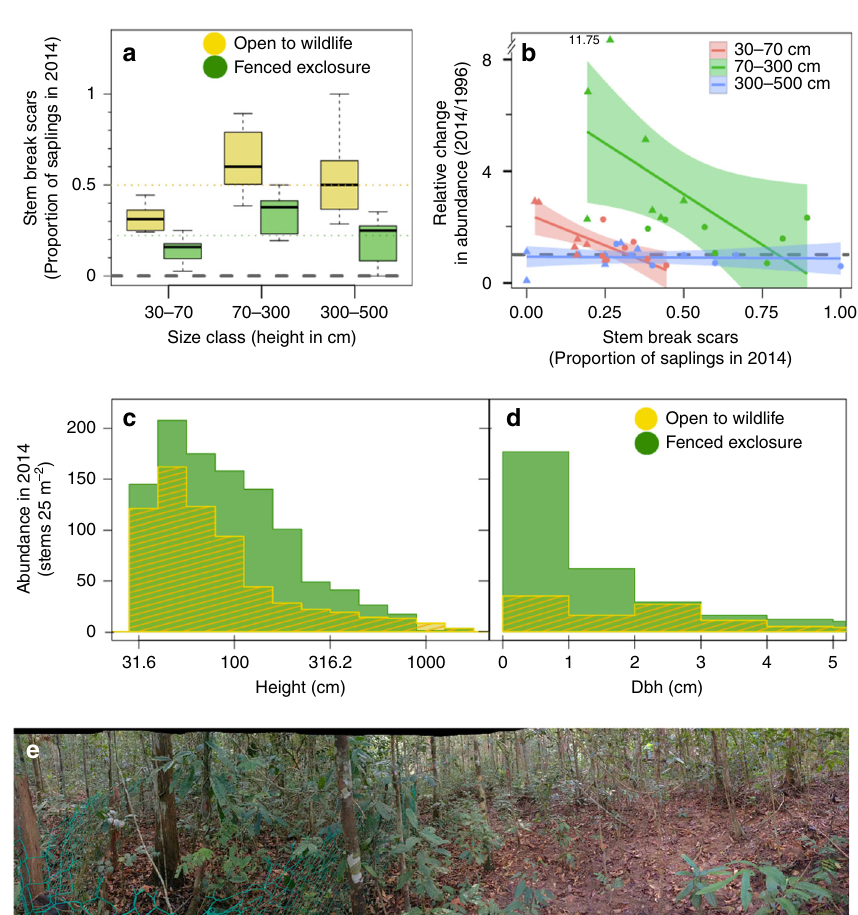
Fig. 3 Impacts of wild boar disturbance on the forest understory. a Different stem break scars in wildlife exclosures (green) compared to open control plots in 2014 (yellow) ( n = seven replicates of 25 m 2 exclosure plots and paired controls). Colored dashed lines show group means. Whiskers represent distance from upper and lower quartiles to largest and smallest non-outliers. b Stem break scars (indicating use in wild boar nests) are associated with a strong reduction in the relative abundance from 1996 to 2014 in small saplings 70 – 300 cm (green), whereas reductions were smaller for seedlings 30 – 70 cm (red) and large saplings > 300 cm (blue) that are not used in wild boars nests. Shaded polygons show 95% con fi dence intervals, triangle data points show wildlife exclosures and circles show open controls plots. Y -axis is broken to accommodate an outlier with 11.75 times greater abundance in 2014 compared to 1996. c Stem height distribution difference between exclosures and controls in 2014 (Kolmogorov – Smirnov test KS, d = 0.1423, P < 0.001). d Dbh size distributions for exclosure and control communities in 2014 (KS, d = 0.29696, P < 0.001). The distinctive shifts wild boar produced on tree stem size distributions were matched in the independent 50-ha FDP dataset (Fig. 4). e Photograph of exclosure experiment showing comparatively dense understory in fenced areas (left) vs. open understory in unfenced control plots (right, credit: